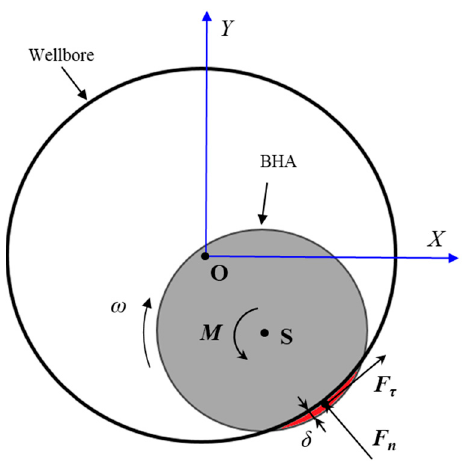
Figure 3. The contact between BHA and wellbore.